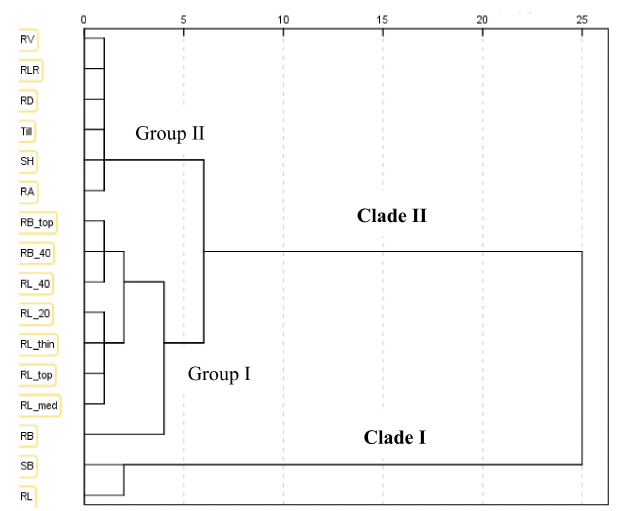
Figure 4. Dendrogram showing clustering patterns of 16 phenotypic traits (13 root traits and